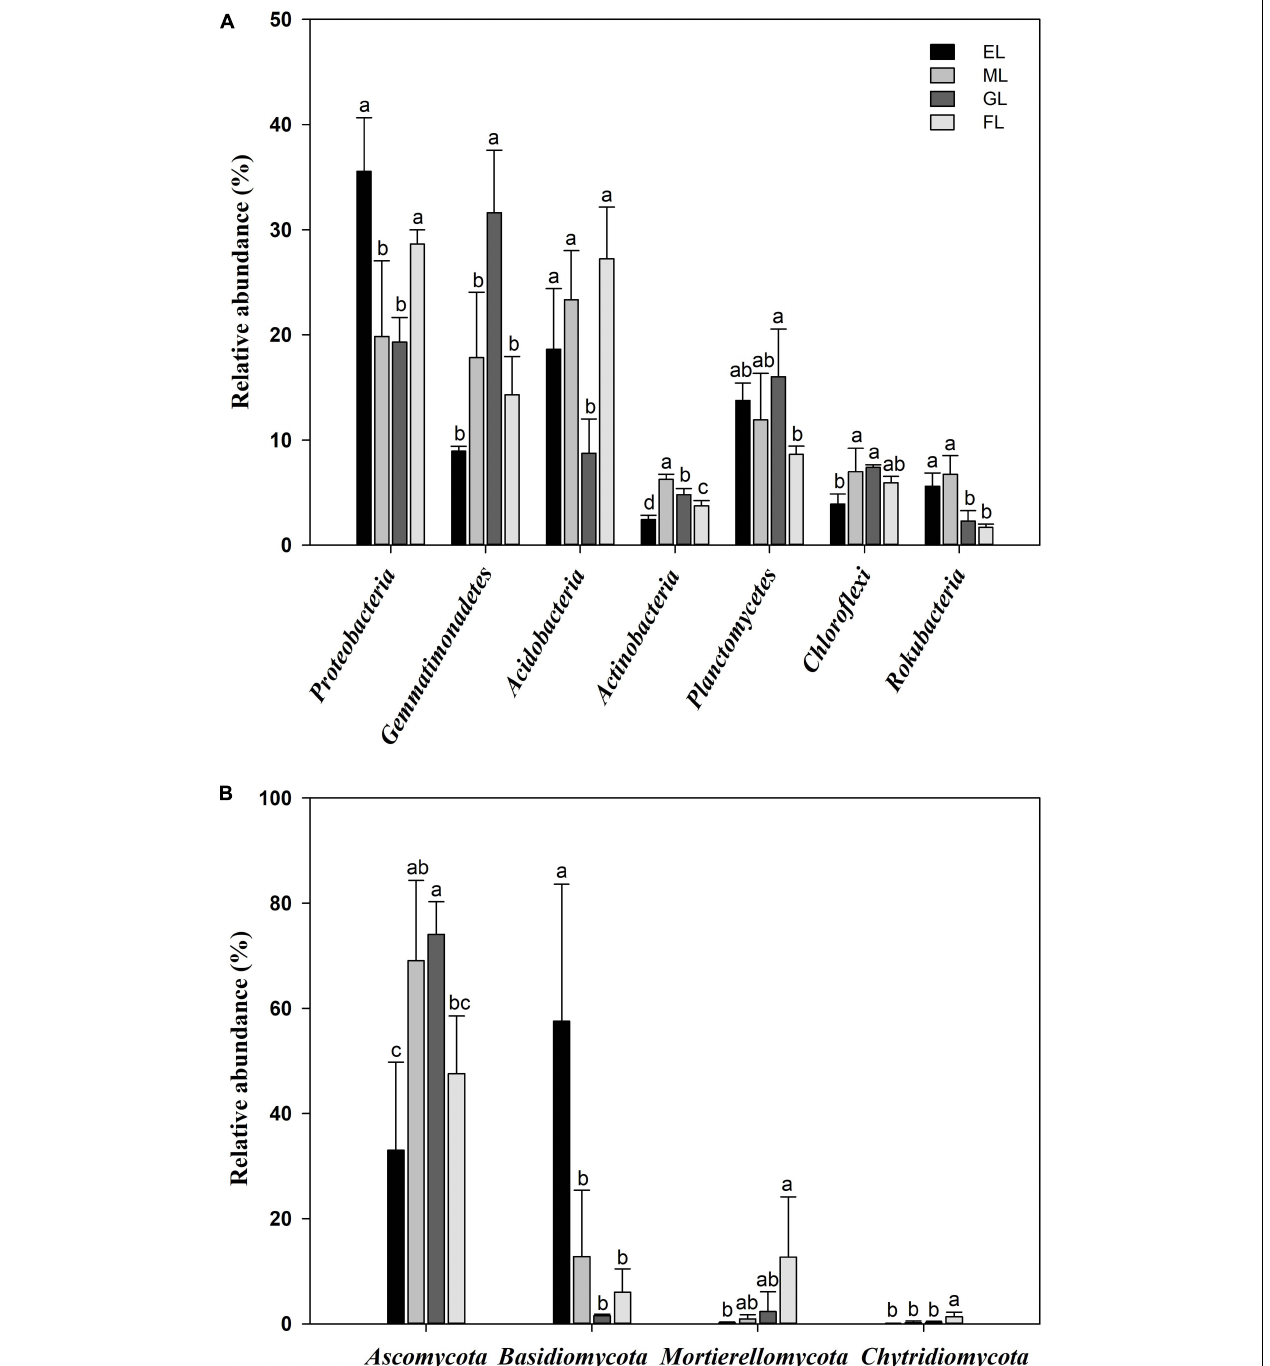
FIGURE 4 | Relative abundances of the dominant bacterial taxa (A) and fungal taxa (B) at the phylum level in different land use types. Different letters indicate a significant difference ( P < 0.05). EL, exclosure; ML, mowed land; GL, grazed land; and FL,